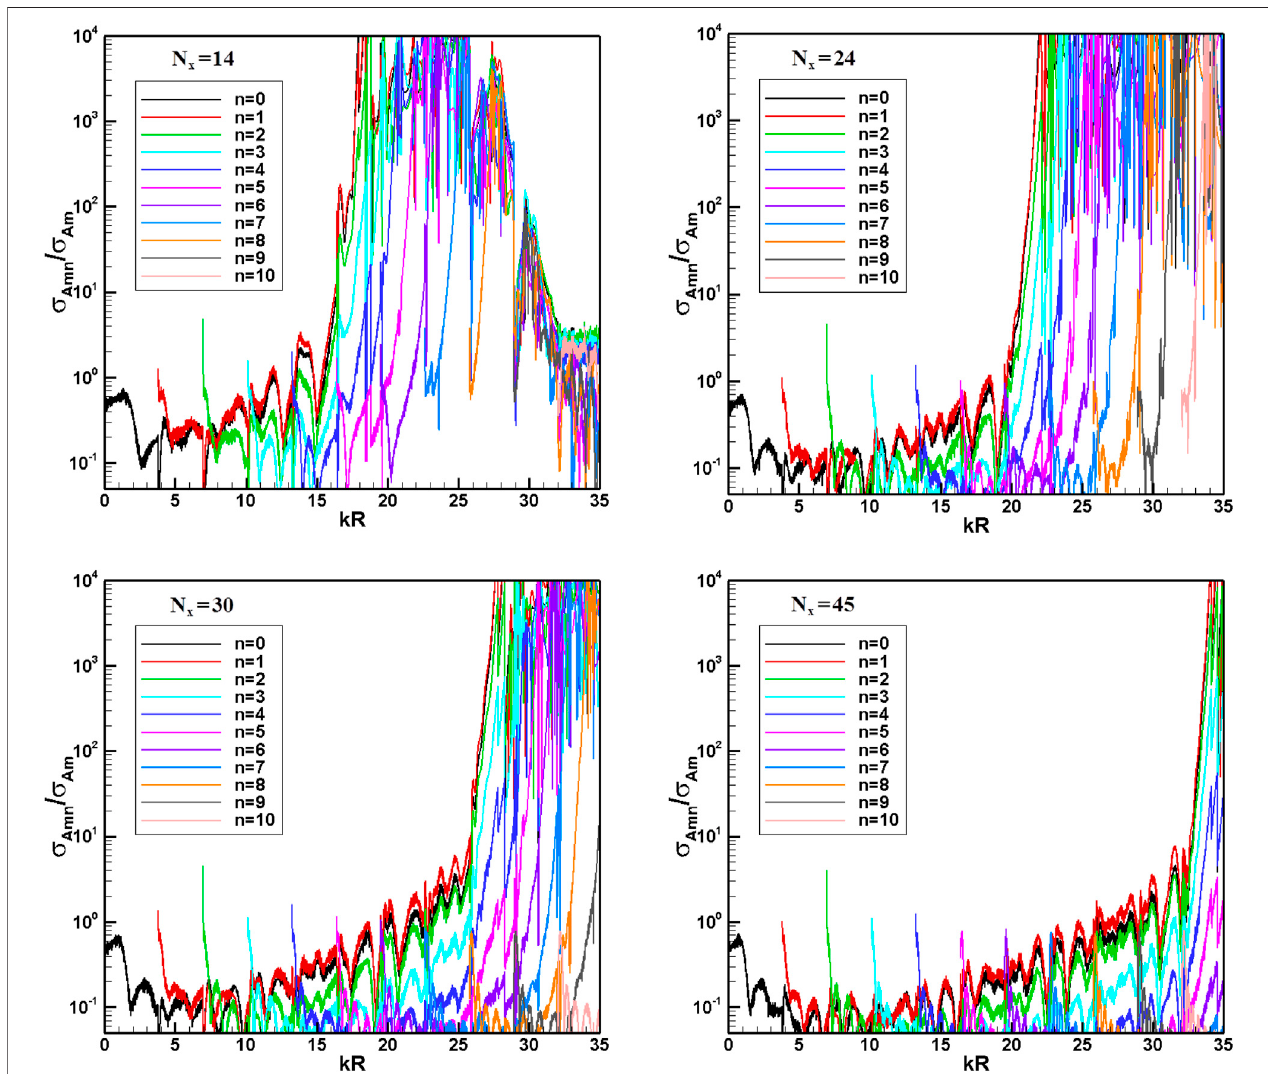
FIGURE 7 | Relative standard deviations σ A